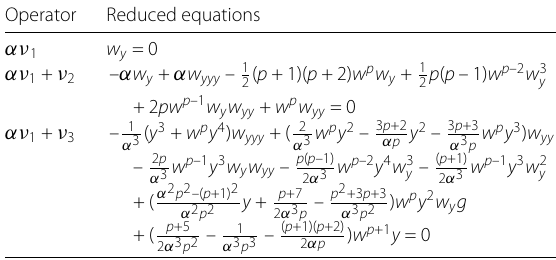
Table 4 Reduction of Eq.